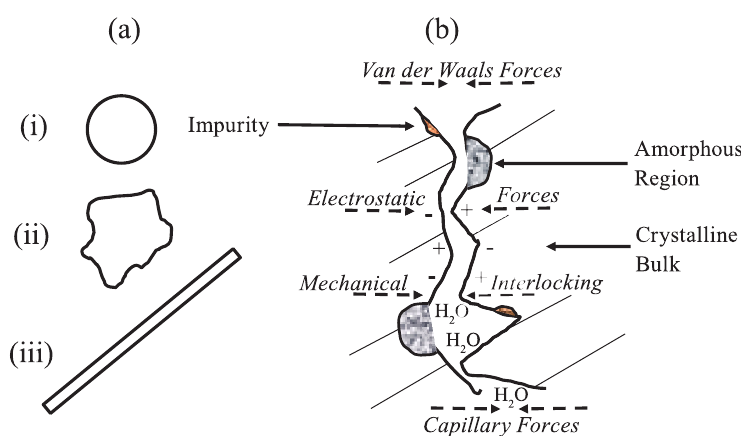
Fig. 3 Schematics illustrating (a) (i) spherical, (ii) rugose or (iii) elongated Particle morphology and (b) Forces of interaction at the interface between two particle